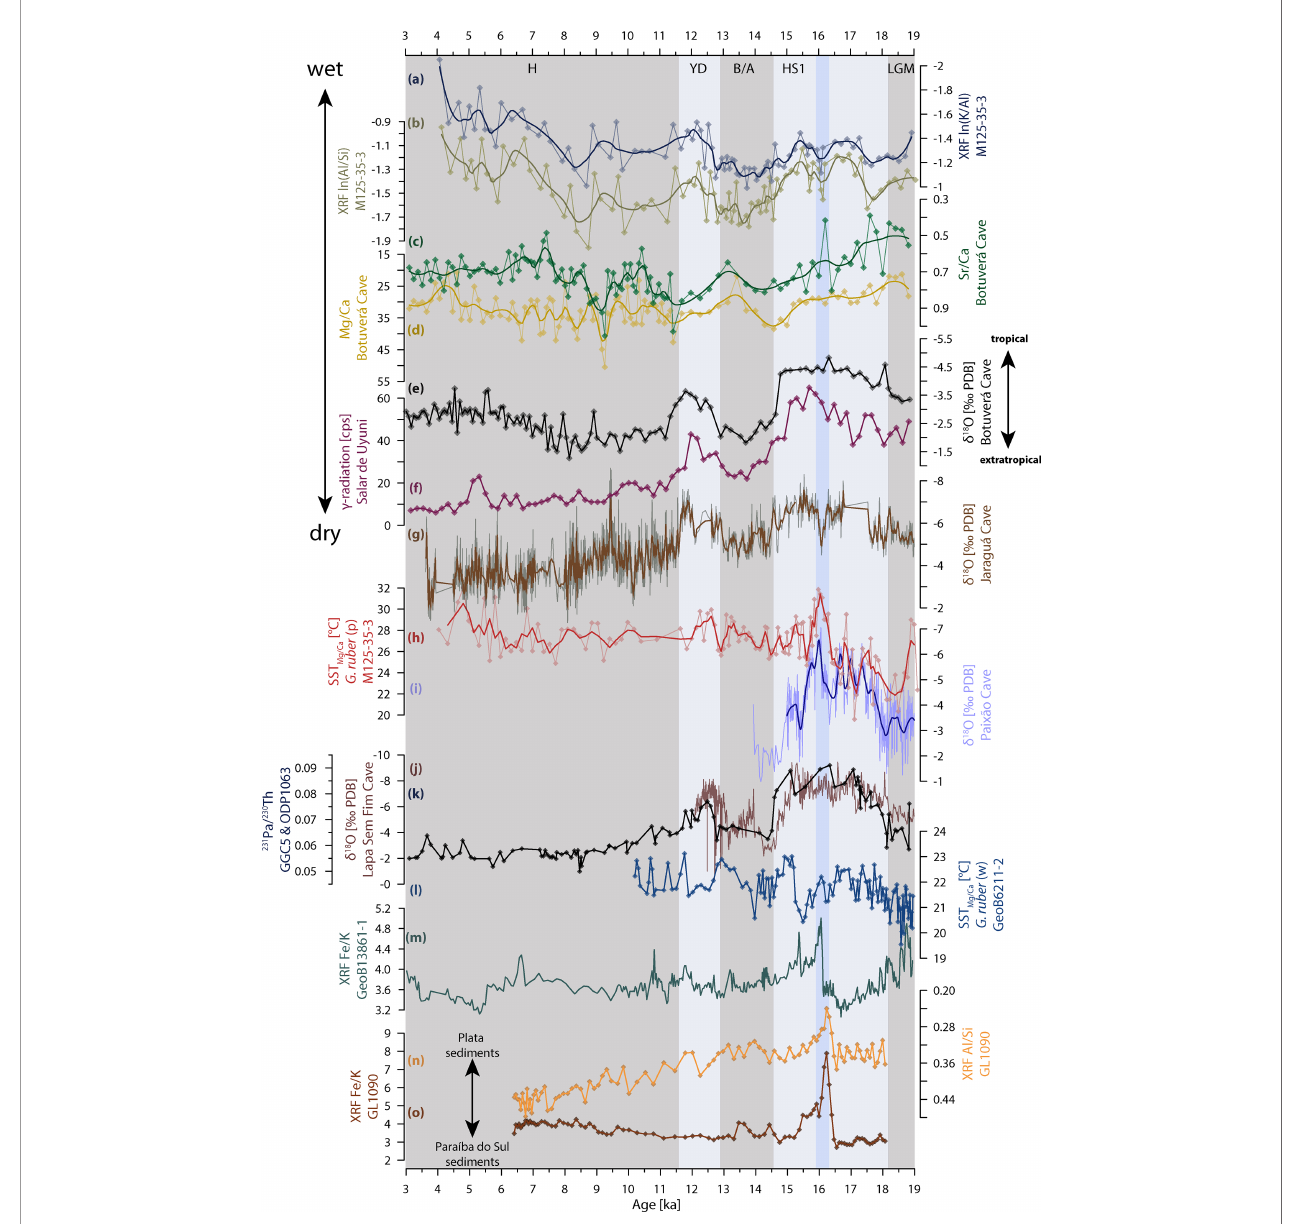
FIGURE 4 | Compilation of paleo precipitation records from South America together with sea-surface temperature (SST) reconstructions from the sub(tropical) South Atlantic. The blue shaded area marks the timing of the atmospheric adjustment to a negative like SALLJ/SACZ dipole pattern across South America at ~16.0 ka as explained in the main text (SALLJ: South American Low Level Jet, SACZ: South Atlantic Convergence Zone). (A) ln(Al/Si)) and (B) ln(K/Al) of Core M125-35-3 (this study). (C) Speleothem-based Sr/Ca, (D) Mg/Ca and (E) d 18 O of Botuvera ́ Cave located in southeastern South America (Cruz et al., 2005, 2007). (F) g -radiation based precipitation record from Salar de Uyuni located in the central Andes (Baker et al., 2001). (G) Speleothem-based d 18 O of Jaragua ́ Cave in central South America (Brazil) (Novello et al., 2017). (H) Mg/Ca-based SST reconstruction from Core M125-35-3 (Meier et al., 2021), (I) Paixão Cave speleothem based d 18 O ‰ records and (J) Lapa Sem Fim Cave speleothem based d 18 O compilation (Str ı ́ kis et al., 2015, 2018) from eastern South America, (K) 231 Pa/ 230 Th compilation from Core GGC5 and ODP Site 1063 representing Atlantic Meridional Overturning Circulation strength (McManus et al., 2004; Böhm et al., 2015; Lippold et al., 2019), (L) SST Mg/Ca record of Core GeoB6211-2 (Chiessi et al., 2015) collected off southern Brazil, (M) XRF-derived Fe/K from Core GeoB13861-1 close to the La Plata River mouth (Warratz et al., 2017). (N) and (O) XRF derived ln(K/Al) and Fe/K from Core GL-1090 from the La Plata River mouth (Mathias et al., 2021). Thick lines in panels a-d and g-i indicate 3-point running average. LGM, Last Glacial Maximum; HS1, Heinrich Stadial 1; B/A, Bølling-Allerød interstadial; YD, Younger Dryas; H, Holocene; MWP1a, Meltwater Pulse